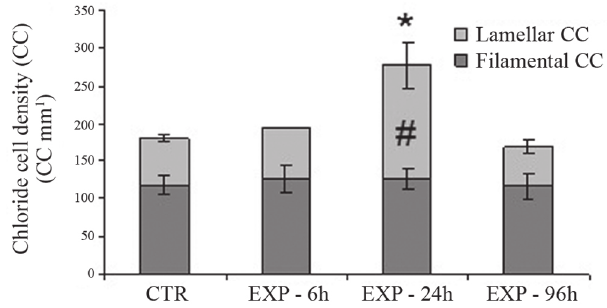
Fig. 6. Activity of Na + /K + -ATPase in the gills of Prochilodus lineatus exposed to WSFG (EXP) or only to water (CTR) for 6, 24 and 96h. Data are means ± SEM (n = 10-13), asterisks indicate different from respective control (P <